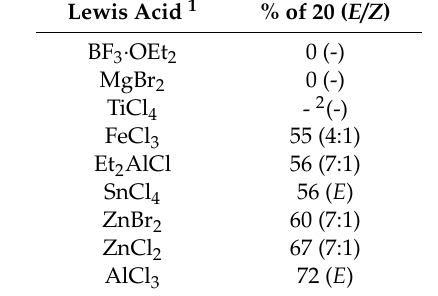
Table 2. Friedel-Crafts alkylation of 18 with sulfonyl 19 to form 20 [65]. Scheme 9. Synthesis of truncated MK-derivatives using Friedel-Crafts alkylation [65]. Lewis Acid 1